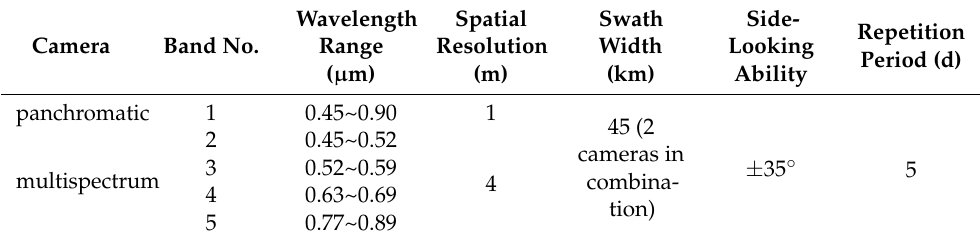
Table 1. Payload parameters of GF-2